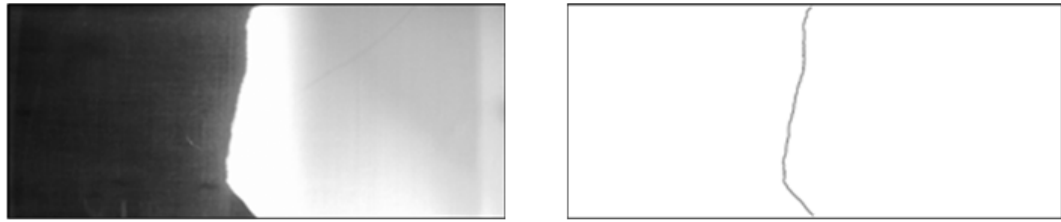
Figure 2. Instantaneous image of resin flow before and after image processing.